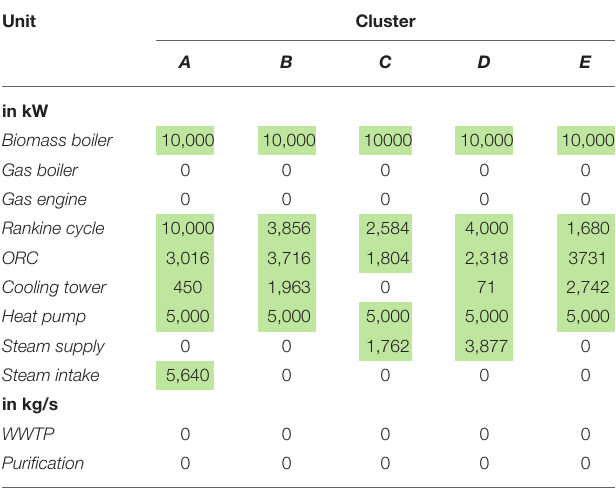
TABLE 3 | Utility unit sizing in each cluster (emissions